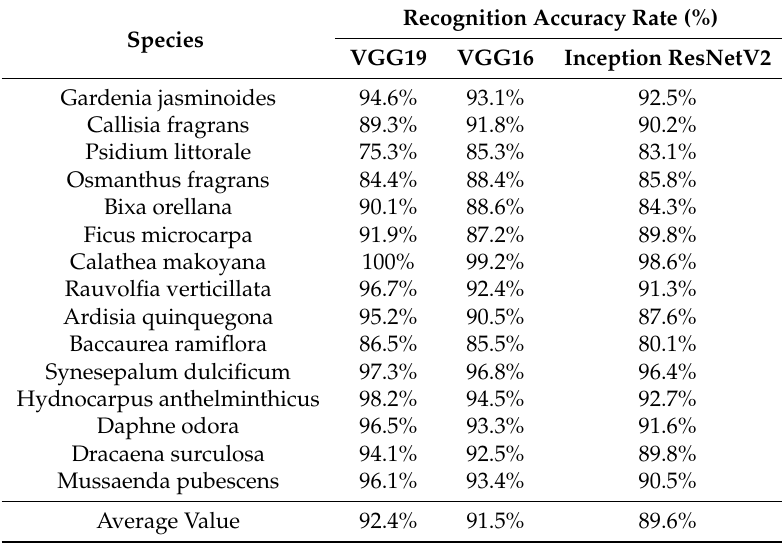
Table 2. The classification accuracy of different neural network